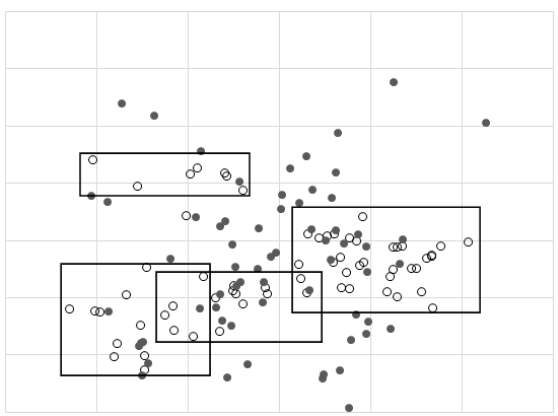
Figure 10. Combination of two metrics using a combination of rectangular regions to discriminate between Positive (white) and Negative (black) classification